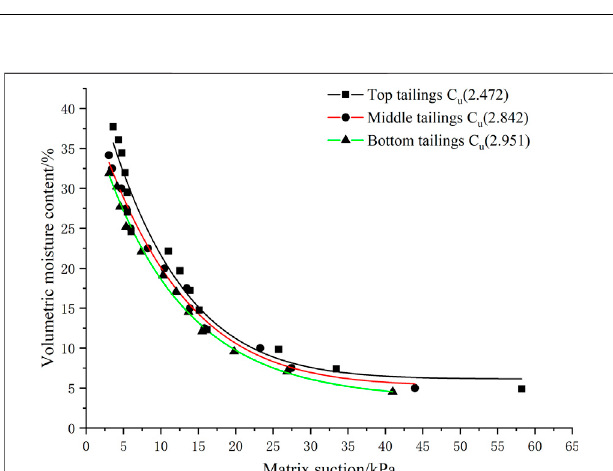
FIGURE 3 | Position relationship between tailings specimens and fi lter paper.